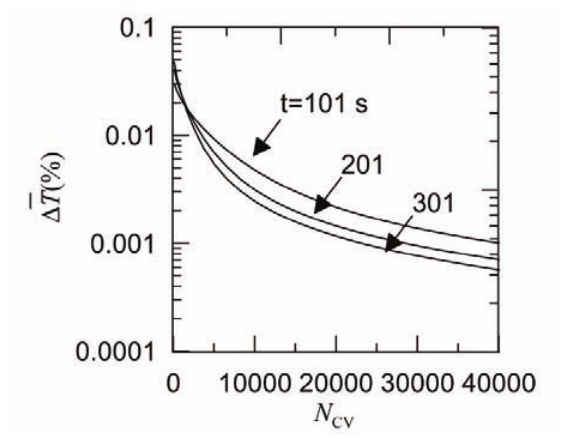
of control volumes of the CV between the u between the actual u